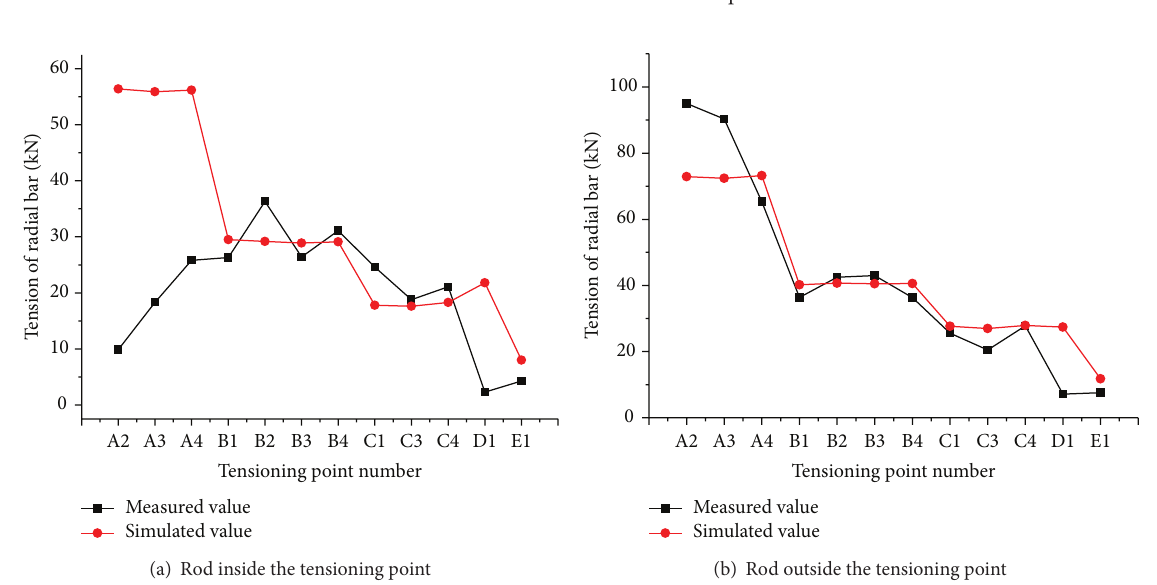
Figure 17: Tension increment of the hoop cable.